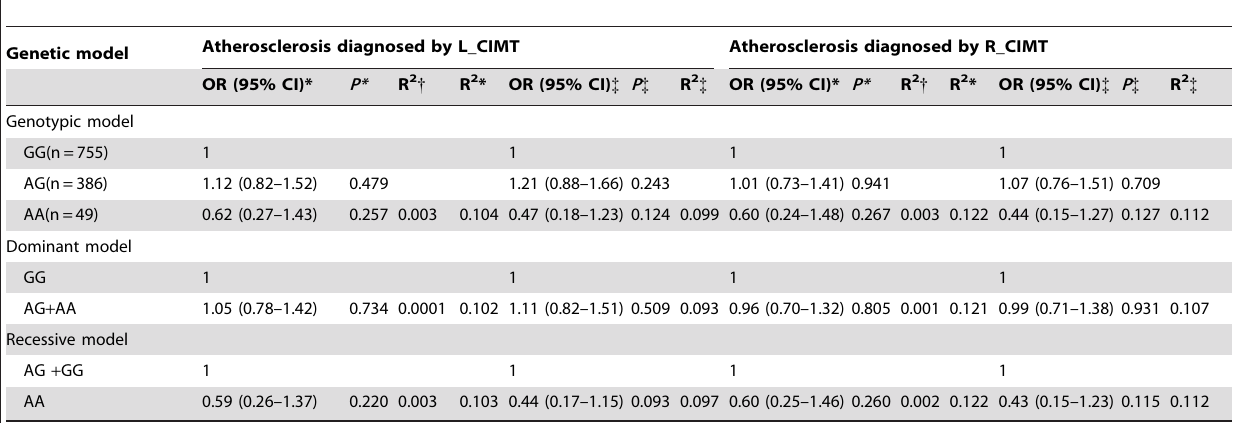
Table 3. Associations of rs2230500 with atherosclerosis diagnosed by CIMT.